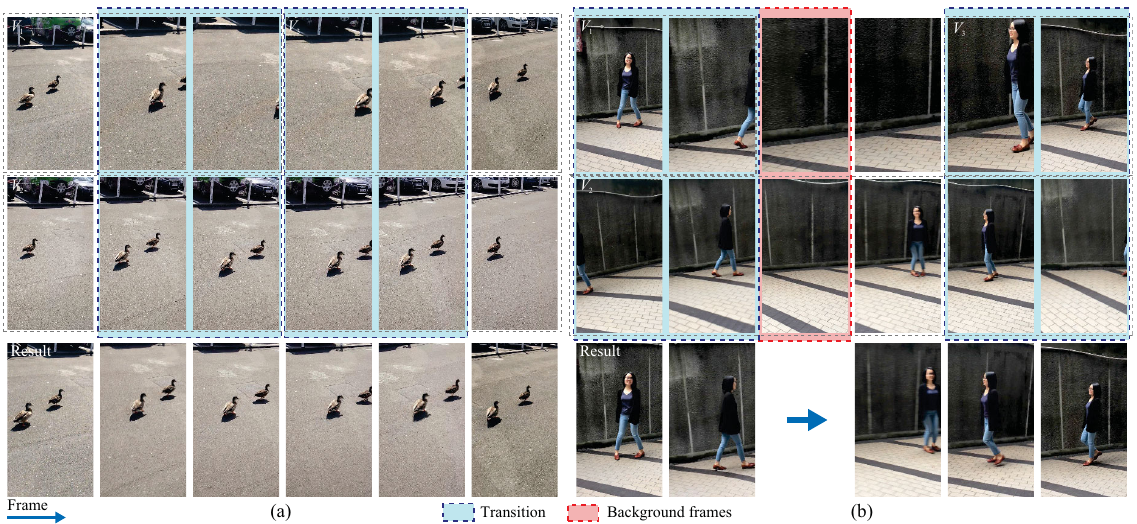
Fig. 12 Additional results. At left we show an example containing two foreground objects. At right we show an example where at one time, all input videos contain only background objects. Our system can find a transition to skip these frames. Please see Section 7.4 for more